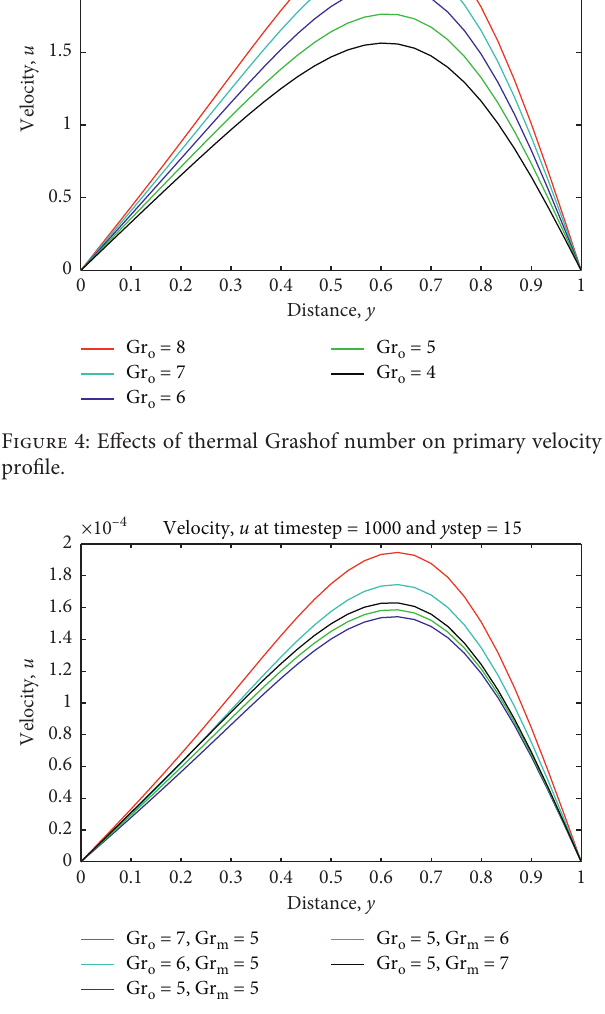
Figure 5: Effects of mass and thermal Grashof number on primary velocity